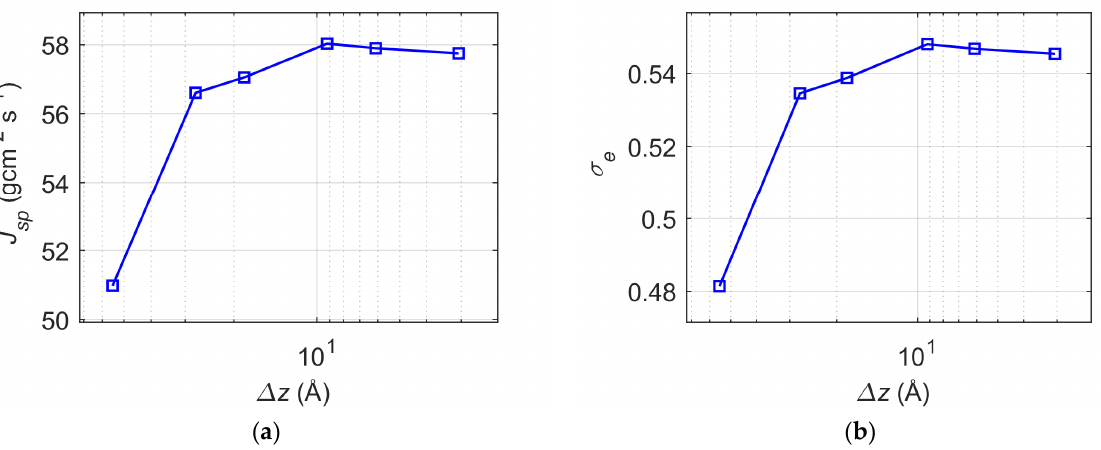
Figure 7. ( a ) The spontaneous evaporation rate, and ( b ) the corresponding evaporation coefficient as a function of the liquid phase division bin width in steady-state vacuum simulations. The first point (55 Å bin width) represents the data point for simulations without the liquid phase division.